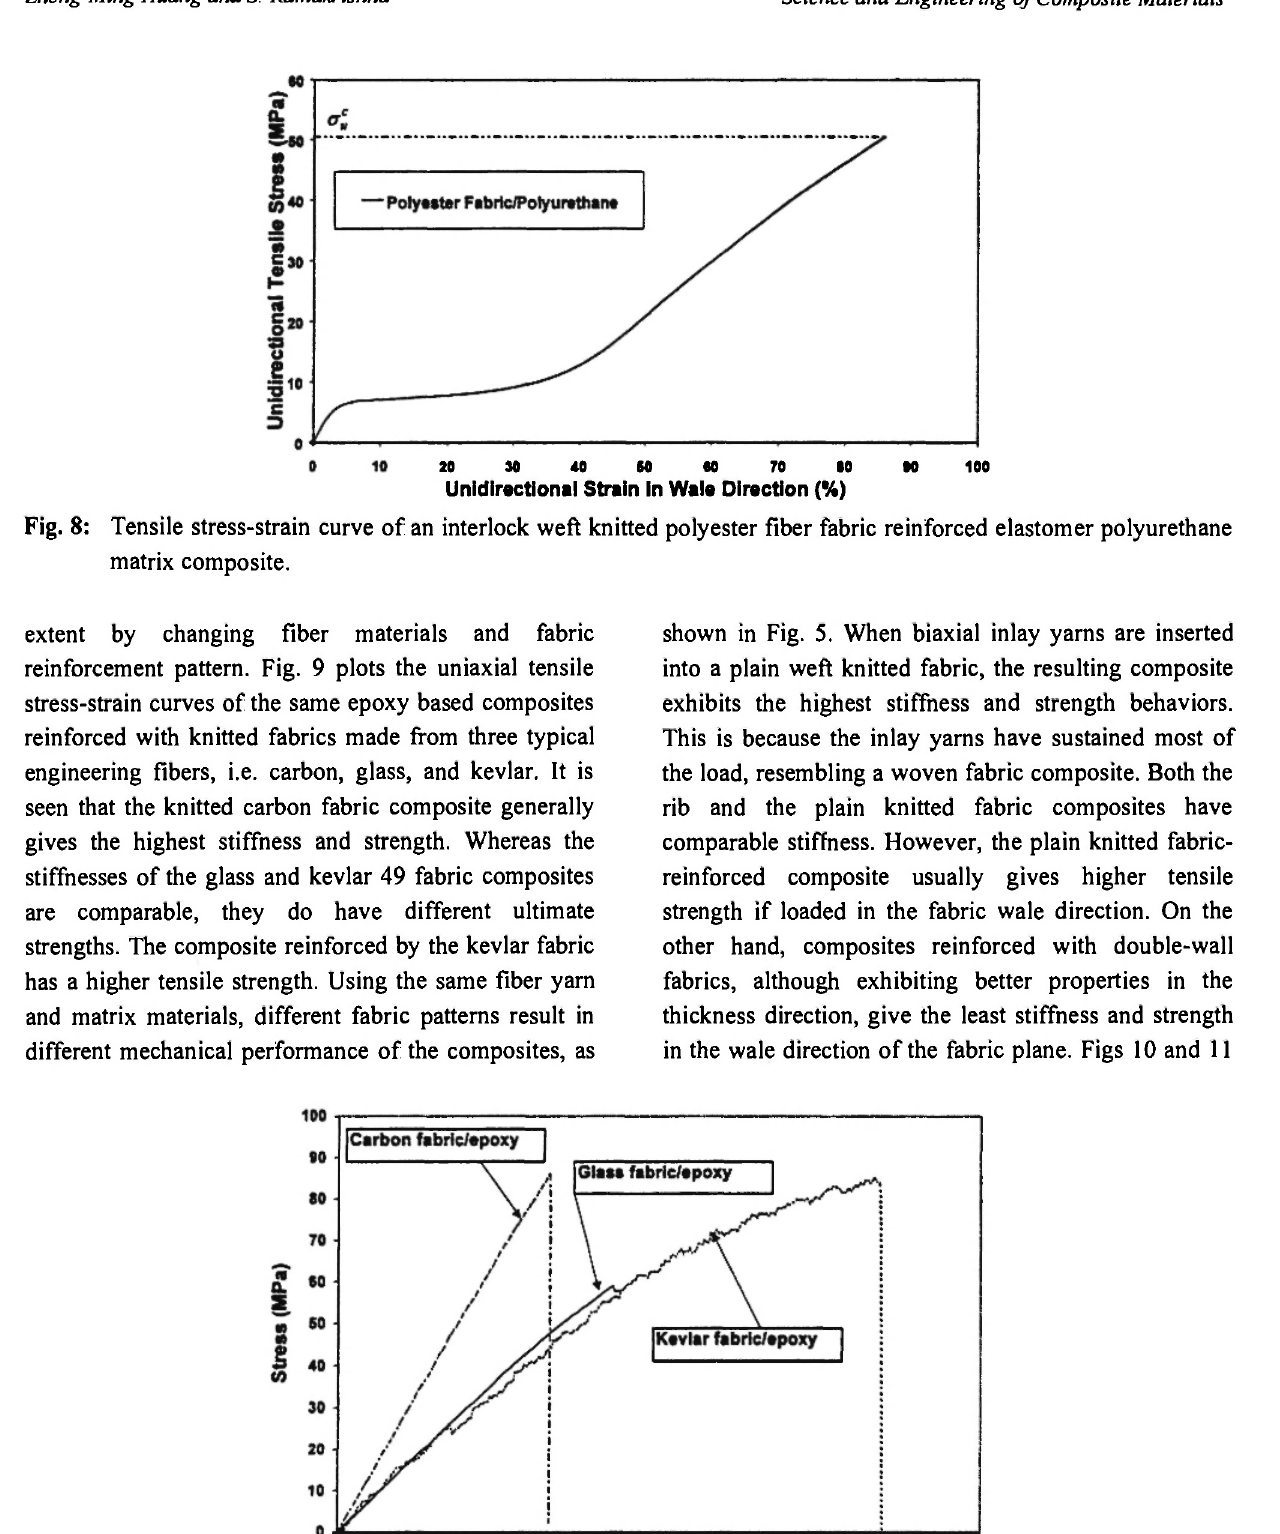
Fig. 9: Typical uniaxial tensile stress/strain curves of plain weft knitted fabric reinforced epoxy matrix composites with different fiber